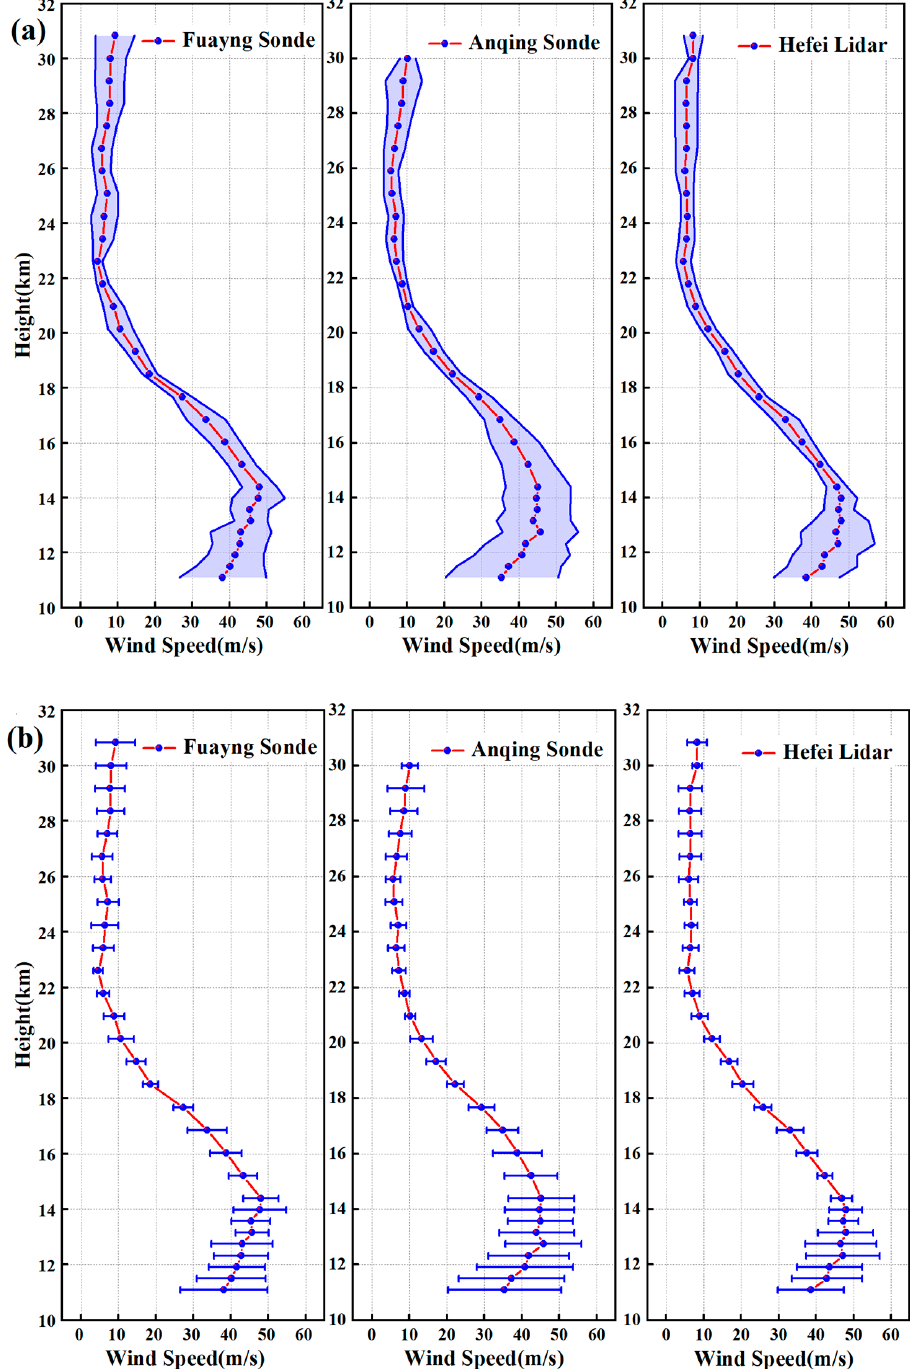
Figure 17. Comparison of atmospheric wind field profiles detected by Doppler wind Lidar and radio sounding instruments from October 23 to November 9. ( a ) Atmospheric wind field changes ( b ) Error bars.